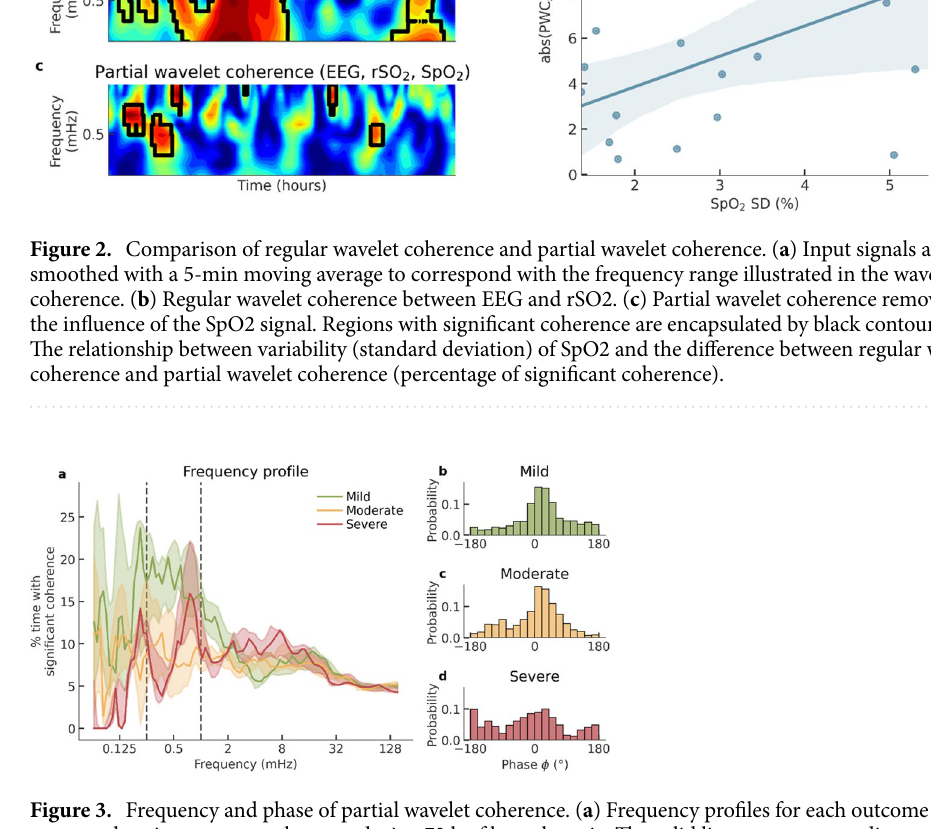
Figure 3. Frequency and phase of partial wavelet coherence. ( a ) Frequency profiles for each outcome group computed as time average coherence during 72 h of hypothermia. The solid line represents median per group and the shaded areas represent the inter-quartile ranges. The vertical dashed lines indicate the frequency band of interest (0.25–1 mHz). ( b – d ) distribution of the phase of the significant coherence in the 0.25–1 mHz band per outcome group. φ ≈ 0 ◦ indicates in-phase